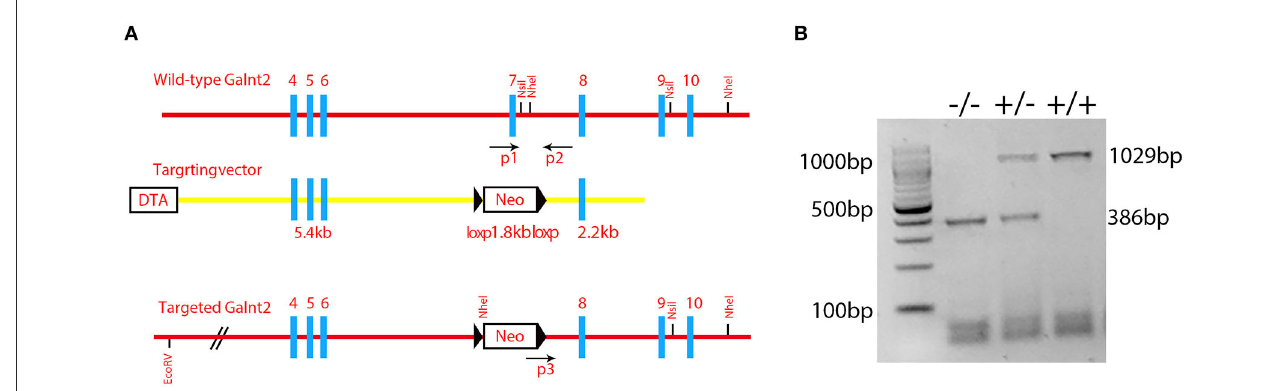
FIGURE1 Identification of the mutant mice. (A) A schematic diagram of the Galnt2 targeting vector, Galnt2 genomic sequence, and the targeted allele. Gray rectangles represent exons; bold blue lines represent the region homologous to the Galnt2 genomic sequence; black triangles represent lox P sites. Neo, neomycin positive selection cassette; DTA, diphtheria toxin negative selection cassette. P1, P2, and P3 indicate genotyping primers. A Neo cassette with flanking lox P sites and homology mini-arms cloned into the Galnt2 sequence to replace the exon 7 that contains the amino acid residues